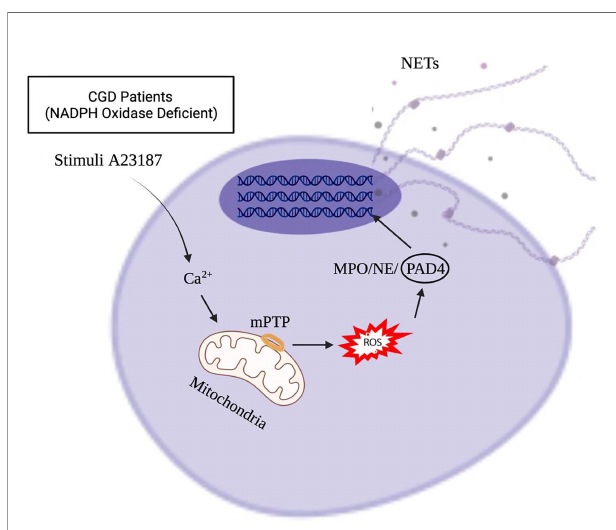
FIGURE 3 | NET formation in X-linked chronic granulomatous disease (CGD) pathway, which is independent of NADPH